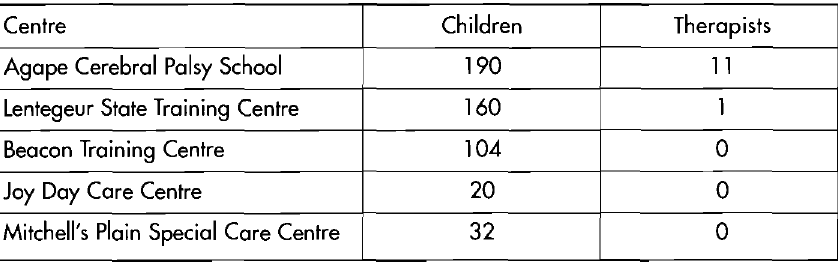
Table 2: Rehabilitation personnel for children at schools and care centres Centre